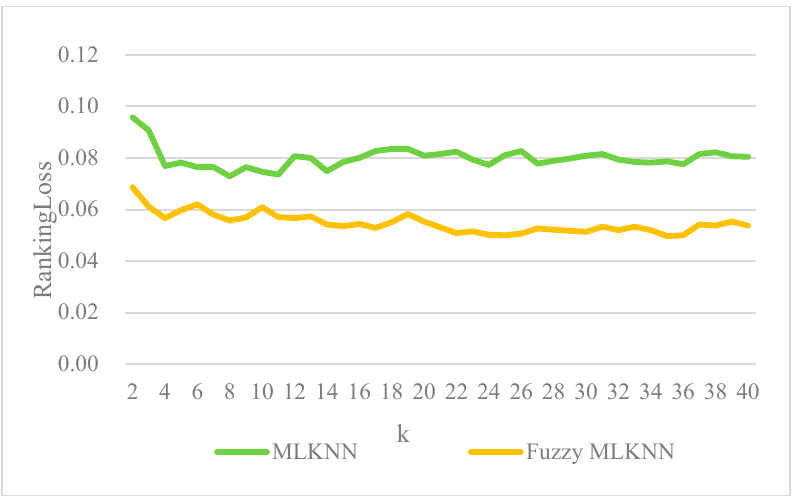
Figure 2. Average_Precision under different K values.